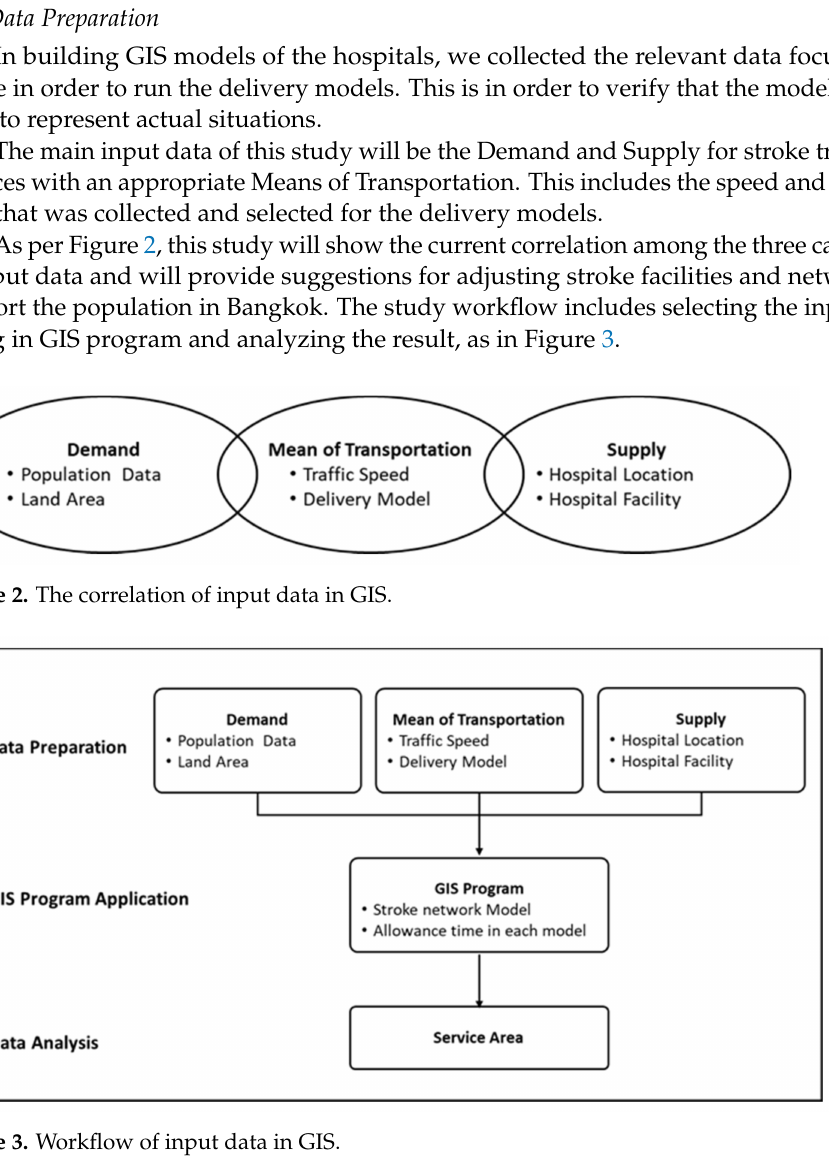
Figure 3. Workflow of input data in